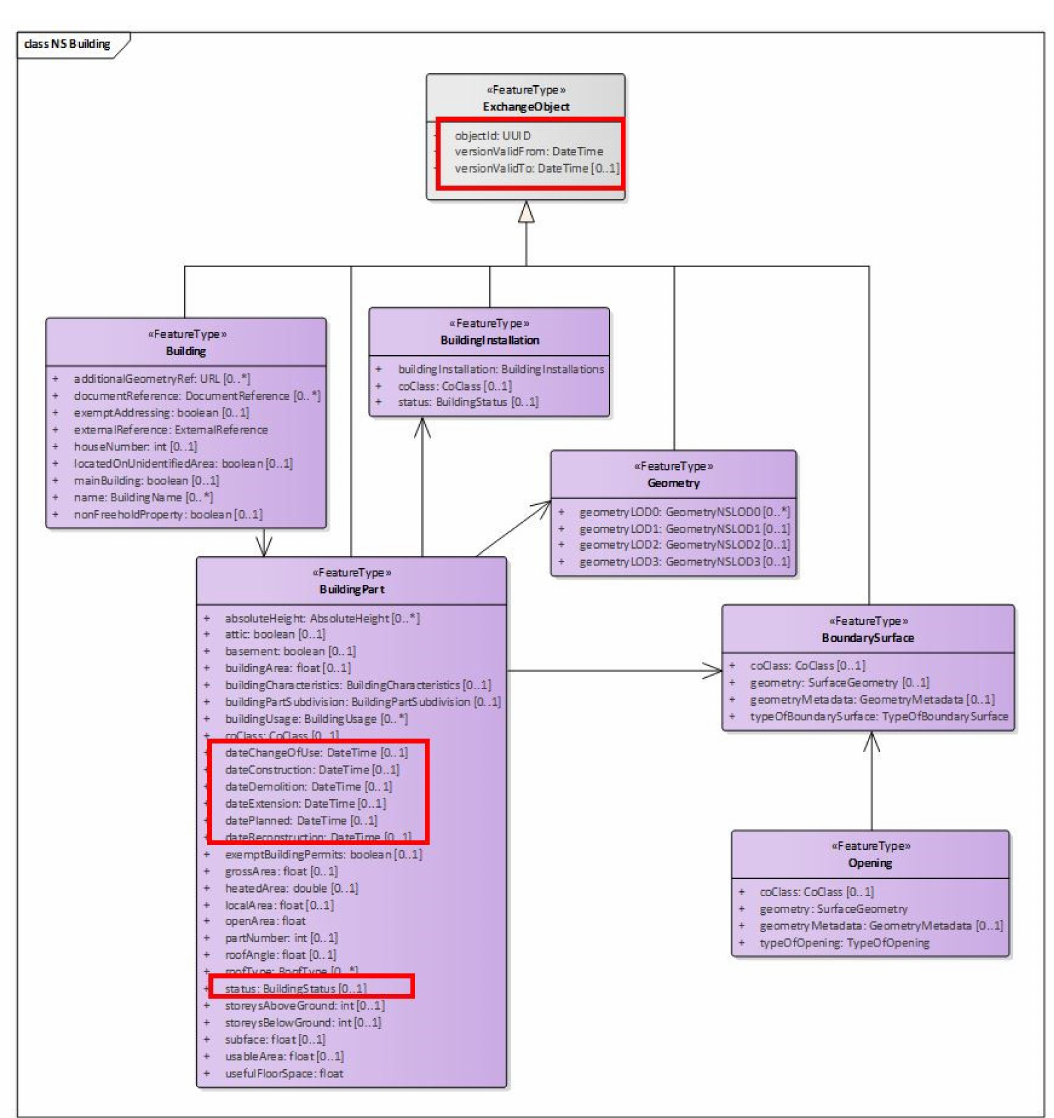
Figure 5. Part of the information model from the proposed Swedish national specification for buildings. Versioning information is marked in red boxes (model translated from Swedish by the